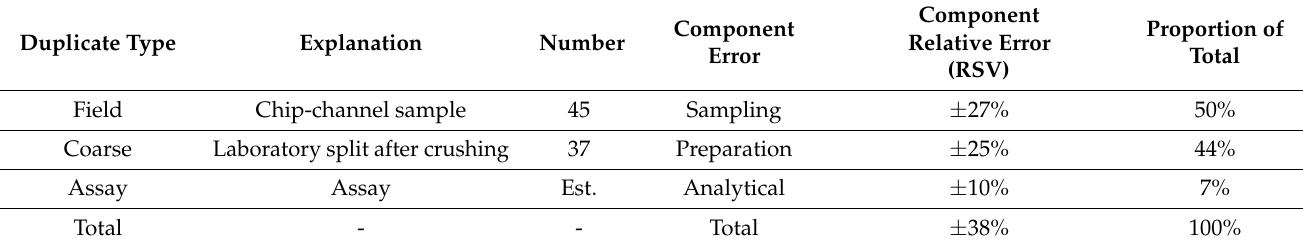
Table 21. Duplicate evaluation of spur vein chip-channel